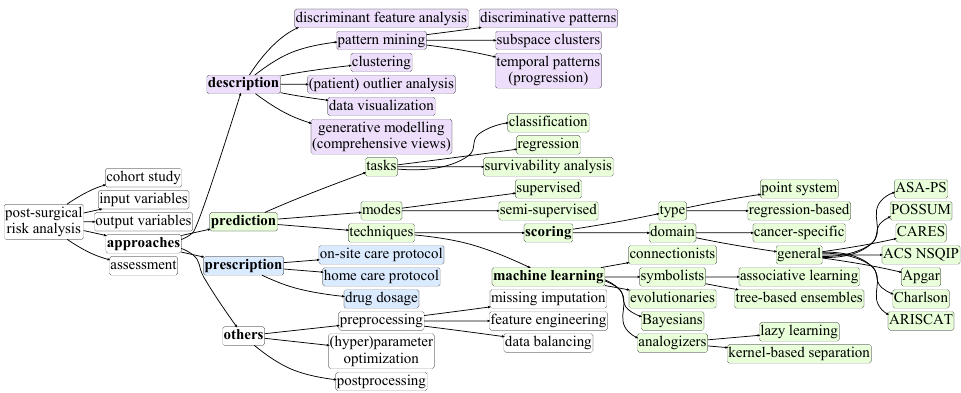
Figure 5. Taxonomy for postsurgical risk analysis: descriptive, predictive and prescriptive approaches ( input–output mapping ).